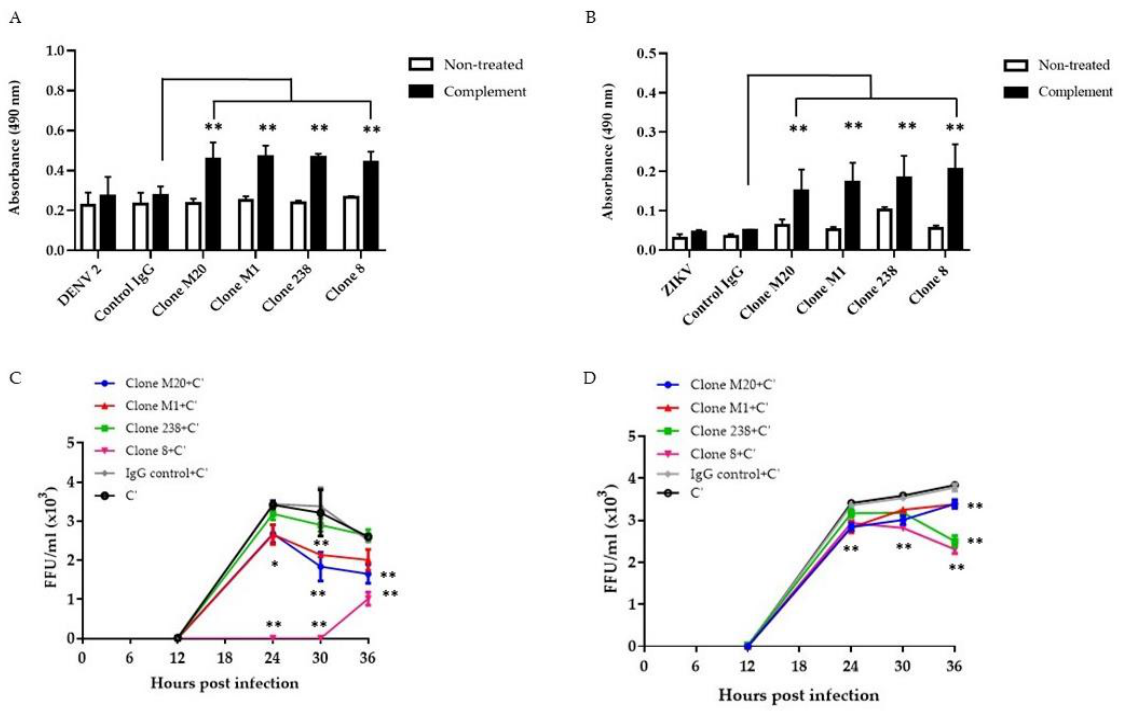
Figure 3. Anti-DENV NS1 HuMAbs stimulate complement-mediated cell cytolysis and inhibition of viral replication: HMEC-1 and HUVECs are infected with ( A ) DENV serotype 2 and ( B ) ZIKV (MOI = 5.0), respectively. At 36 h post-infection, cells are incubated with four anti-DENV NS1 Hu- MAbs (clones M20, M1, 238, and 8) (100 µg/mL) or control IgG for 30 min at 37 °C with complement (C’) for 4 h at 37 °C. The culture supernatants from all groups under each condition are determined for cell cytolysis by detecting the release of lactate dehydrogenase (LDH) (** p- value < 0.01). At 6 h post-infection, ( C ) DENV-infected HMEC-1 or ( D ) ZIKV-infected HUVECs are incubated with four anti-DENV NS1 HuMAbs (M20, M1, 238, and 8) (100 µg/mL) or control IgG at different timepoints with complement addition. Viral titers in supernatants are measured using focus forming assay as FFU/mL. The results presented as the mean ± SD of duplicate independent experiments in different time points (* p- value < 0.05; ** p- value < 0.01 compared with C’ plus control IgG). 3.3. Anti-DENV NS1 HuMAbs Protect against NS1-Induced Endothelial Leakage NS1 is the viral toxin counterpart of bacterial endotoxin lipopolysaccharide, which contributes to vascular leakage in patients with dengue [13]. A previous study reported that NS1-immune serum and anti-NS1 mouse Abs blocked NS1-induced endothelial per- meability [15]. To test the potential effects of DENV NS1 HuMAbs against NS1-triggered endothelial dysfunction, DENV NS1 and ZIKV NS1 alone (10 µg/mL) were incubated with HMEC-1 and HUVECs, respectively. Both cell lines were cultured on a Transwell perme- able membrane as a supportive device to imitate cell barrier functions in vitro. Endothelial changes were examined by measuring the HRP activity. Untreated cells were used as a negative control. The incubation of NS1 (10 µg/mL) markedly disrupted the integrity of HMEC-1 (Figure 4A) and HUVECs (Figure 4B). Expectedly, anti-E HuMAb did not inhibit NS1-induced cell permeability. Notably, DENV NS1 HuMAb M20 and 8 significantly blocked the ability of NS1 to trigger endothelial leakage compared with no treatment or NS1 administration alone (Figure 4A). Similar results were observed in HUVECs incu- bated with ZIKV NS1 (Figure 4B), indicating that DENV NS1 HuMAbs have a potential therapeutic effect against flavivirus NS1-induced endothelial permeability.